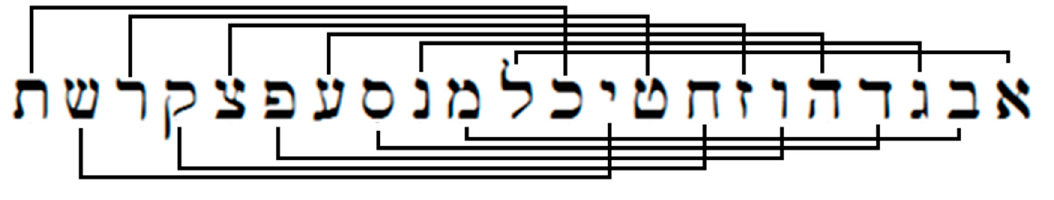
Figure 13. Hebrew alphabet showing the cryptographic substitutions of Atbash encryption. The painting indicates two clearly distinct segments: the seven first letters corresponding to the right-hand side of the Christ’s neckline, and the remaining part, with two letters. After ciphering